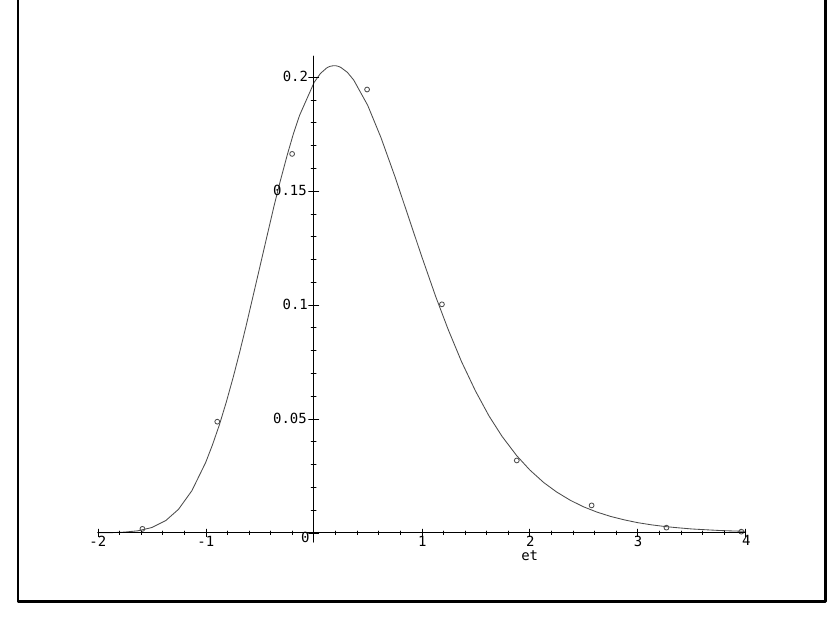
Fig. 5: Maximum part size distribution ( m